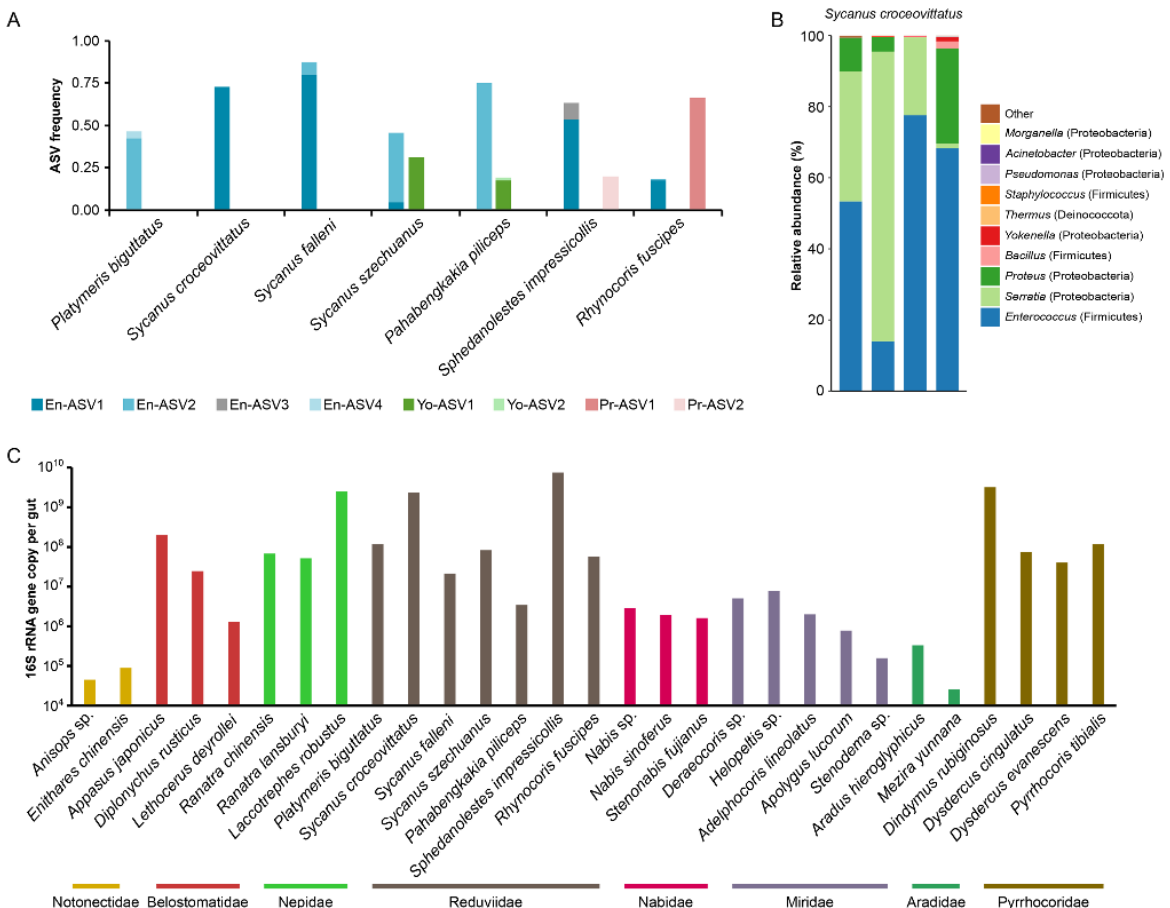
Figure 3. ( A ) The ASV compositions corresponding to the dominant bacterial genera (>20%) com- prising the gut microbiota of assassin bugs. The ASVs from the same bacterial genus are stacked together. ( B ) The frequencies of the top 10 abundant bacterial genera across individuals of species Sycanus croceovittatus . ( C ) The quantitative results for the gut bacterial size of bugs among different heteropteran families.